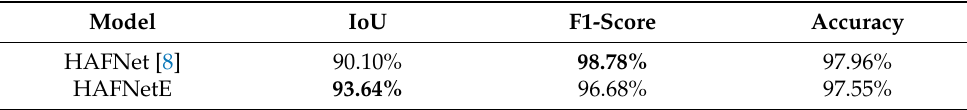
Table 5. HAFNetE and HAFNet performance